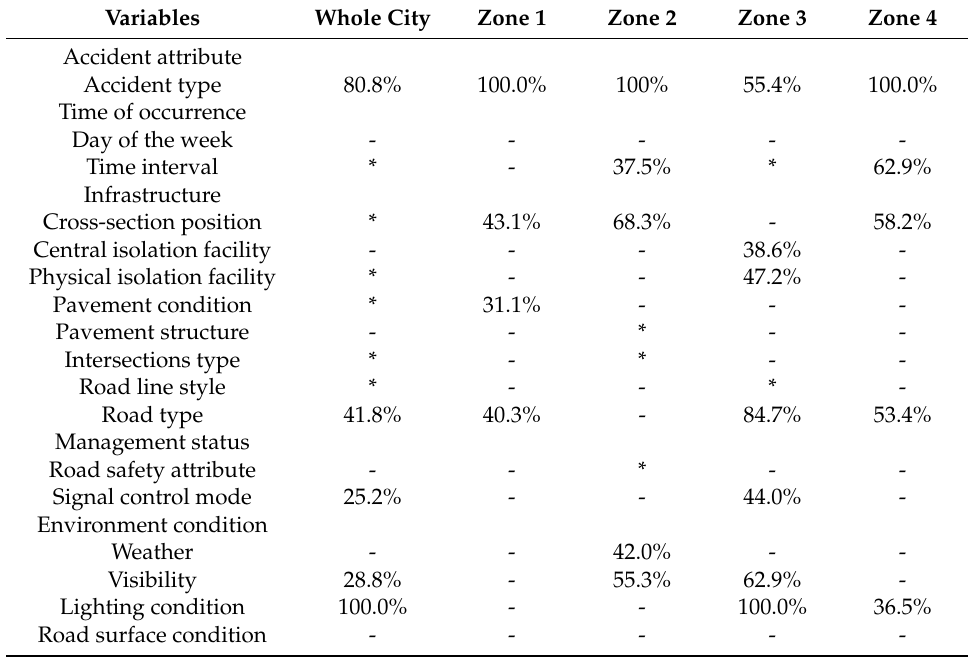
Table 7. Classification and regression tree